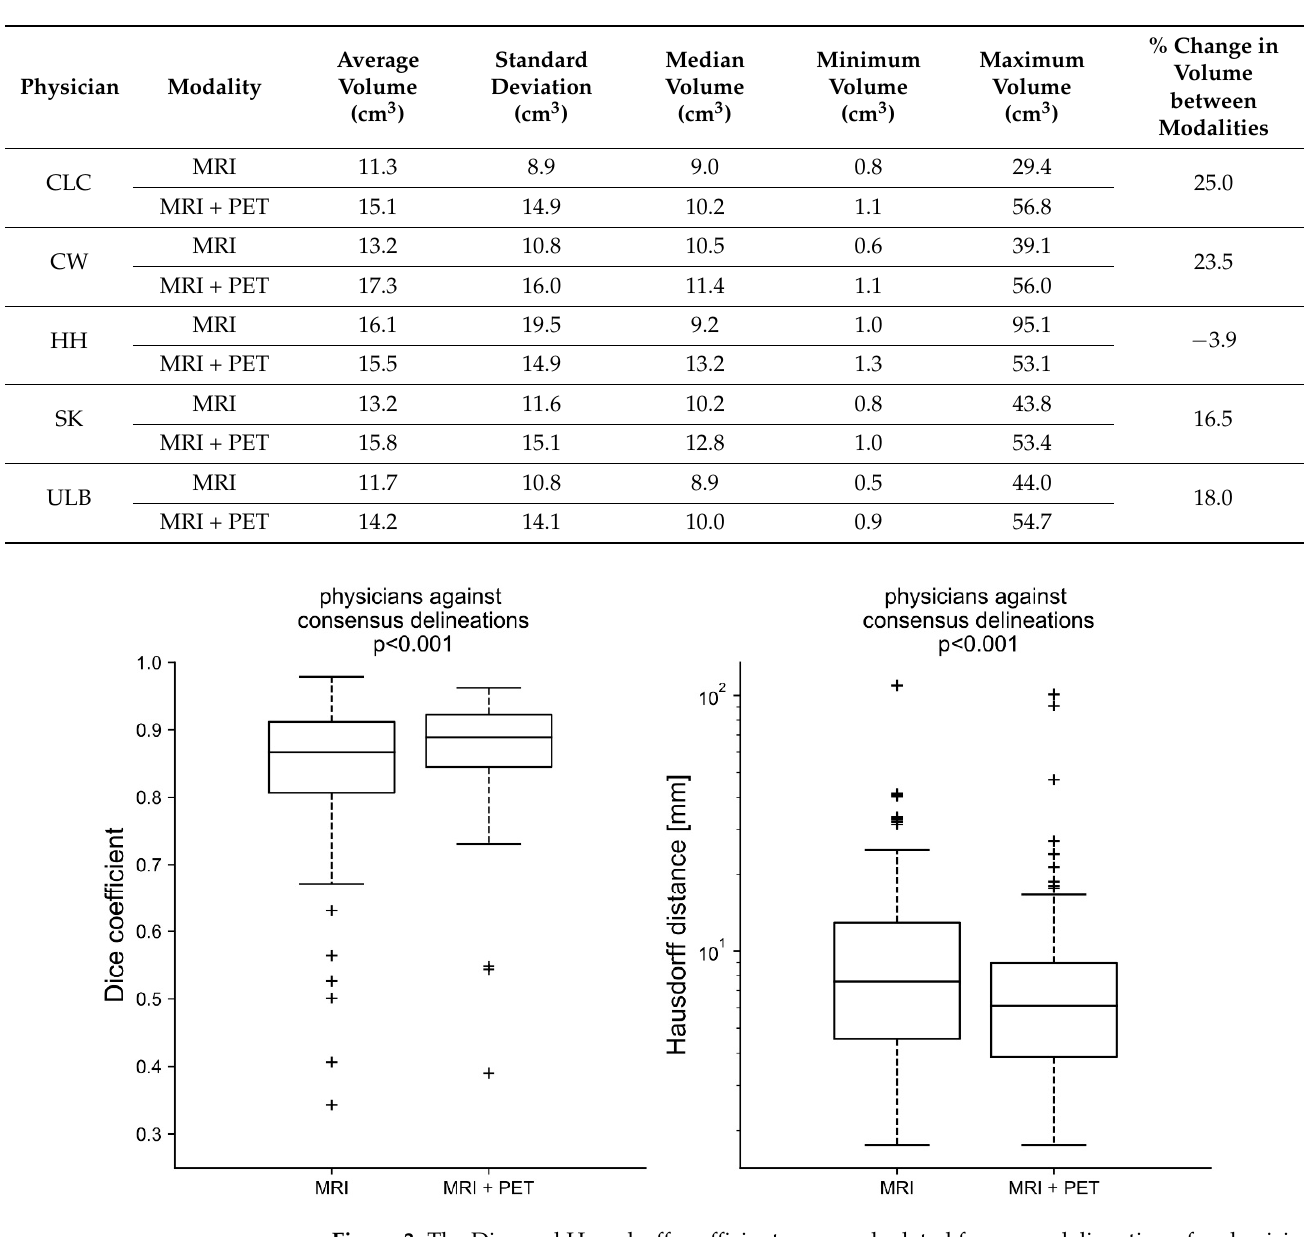
Table 2. Summary of the volumes of the delineations by the respective physicians. The percentage change in volume between the delineations based solely on MRI and MRI + PET images is given in the last column.